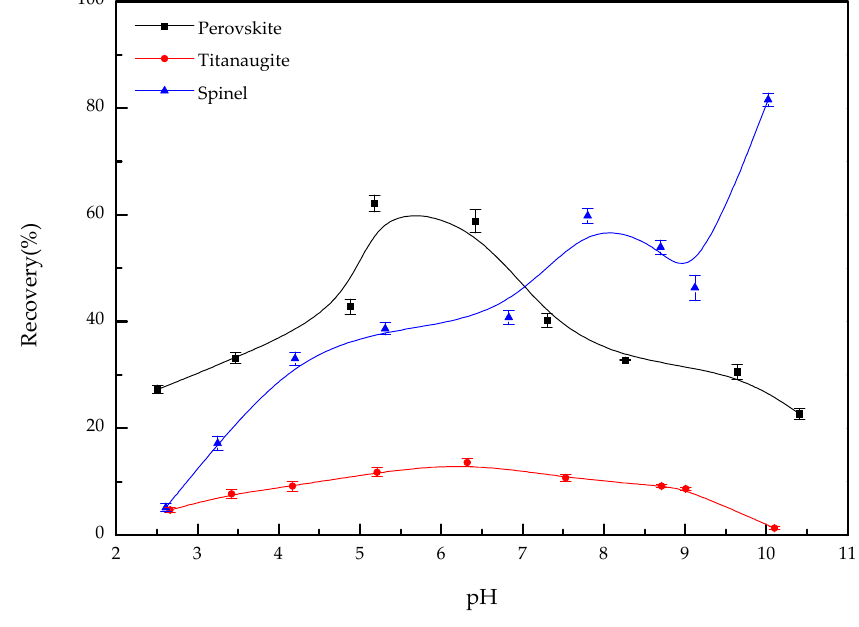
Figure 4. Flotation recovery of minerals as functions of pH ( c OHA = 0.5 × 10 − 4 M).